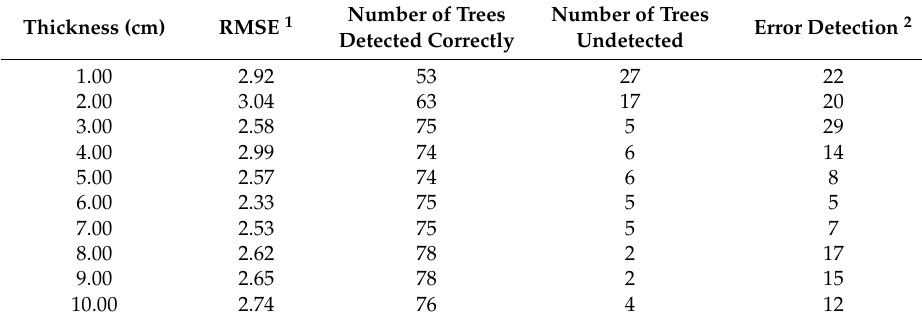
Table 3. Point Cloud Thickness and Accuracy.